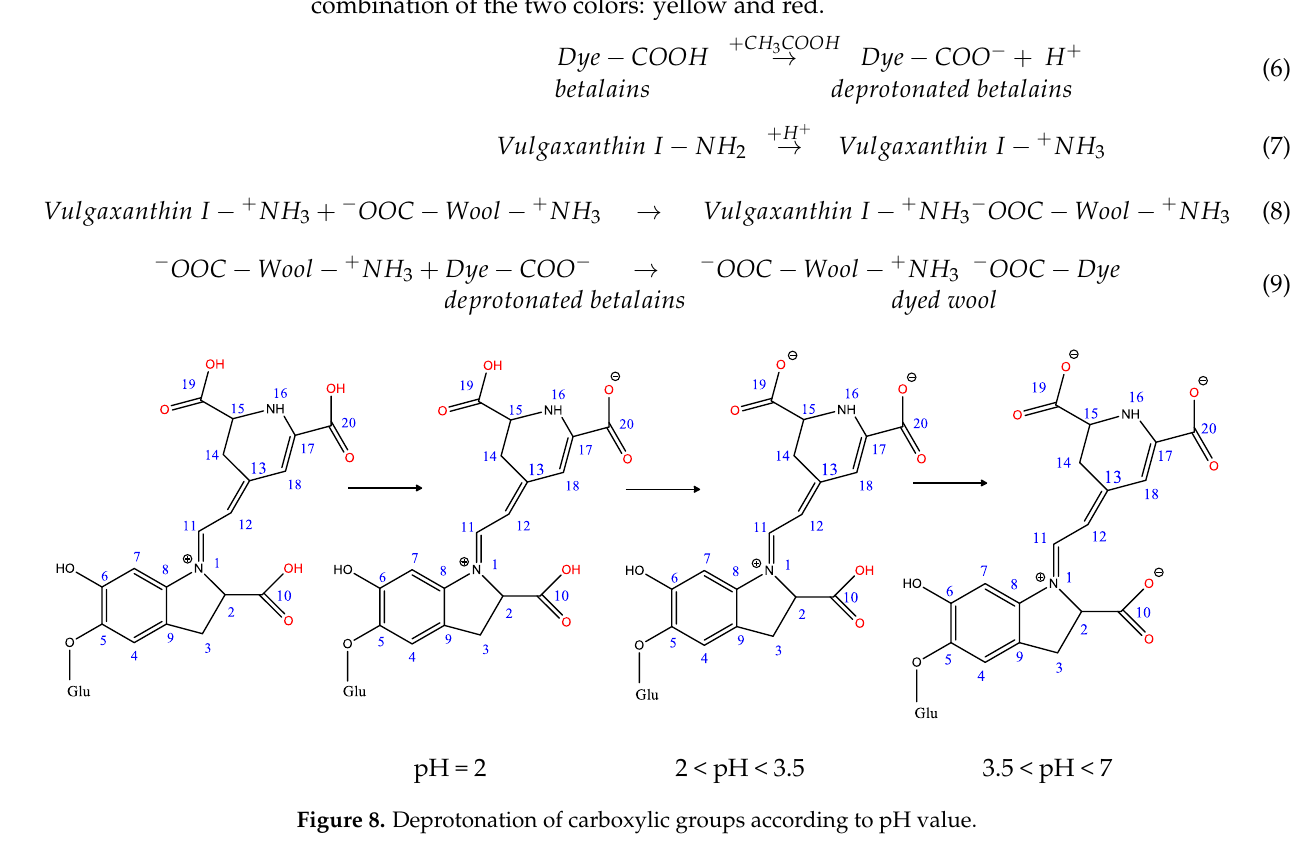
Figure 8. Deprotonation of carboxylic groups according to pH value. The ability of betalains to deprotonate also depends on pKa values; thus, betanin can generate mono-deprotonated, di-deprotonated, and tri-deprotonated forms in the presence of water molecules [32] (Figure 9).